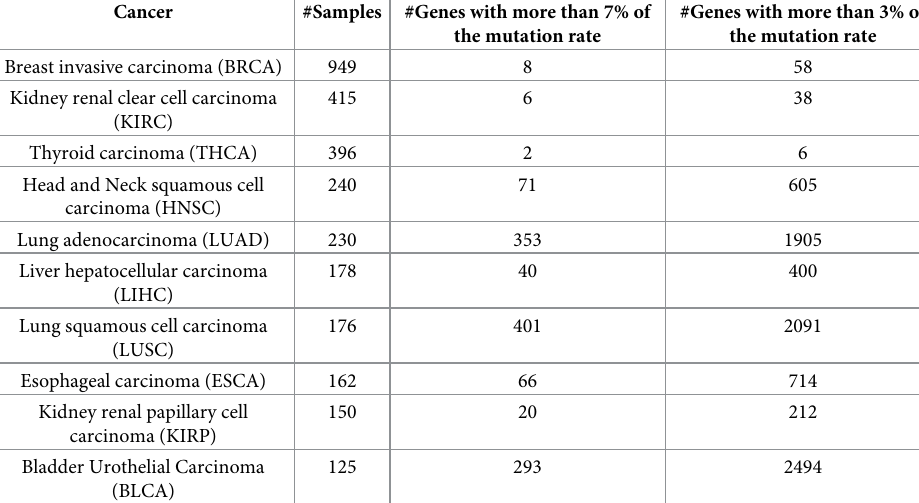
#Genes with more than 3% of the mutation rate the mutation rate